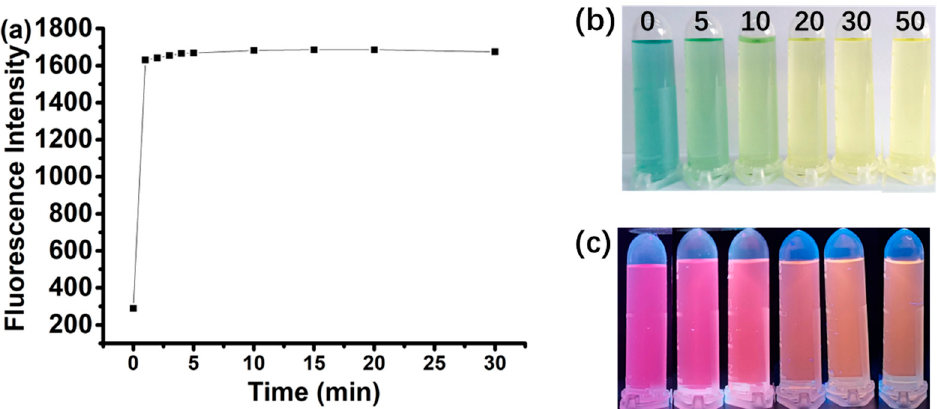
Figure 2. ( a ) Linear relationship between fluorescence intensity at 574 nm and response time in the concentrations of DCP (50.0 µM). ( b ) Color changes in the reaction of different concentrations of DCP (0, 5.0, 10.0, 20.0, 30.0, 50.0 µM) with SWJT-20 under visible light. ( c ) Color changes in different concentrations of DCP (0, 5.0, 10.0, 20.0, 30.0, 50.0 µM) with SWJT-20 under UV light.